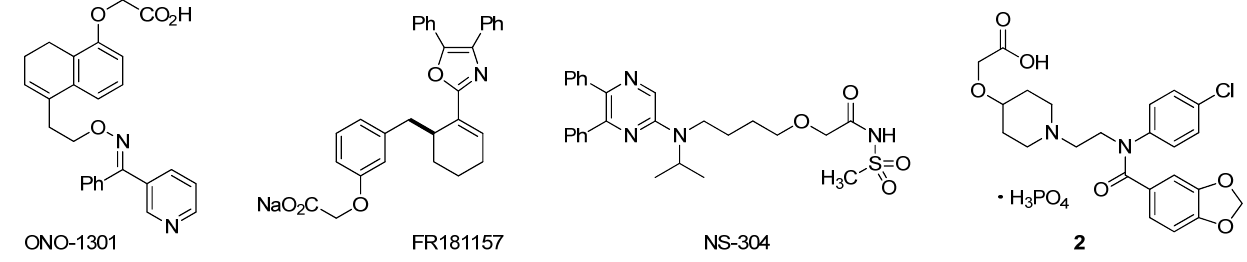
Figure 2. Chemical structure of non-prostanoid PGI